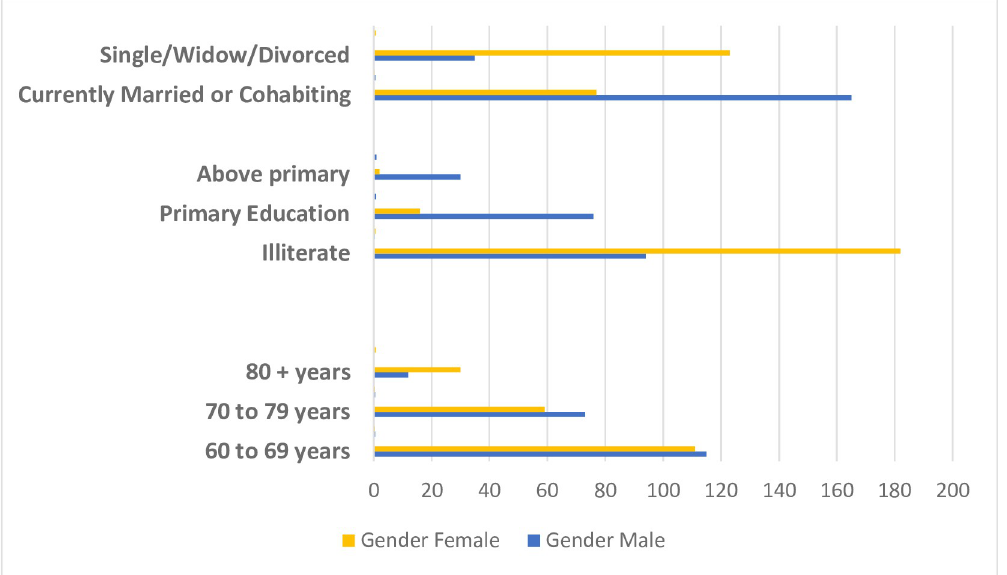
Fig 1. Distribution of age, education and marital status of indigenous older adults by